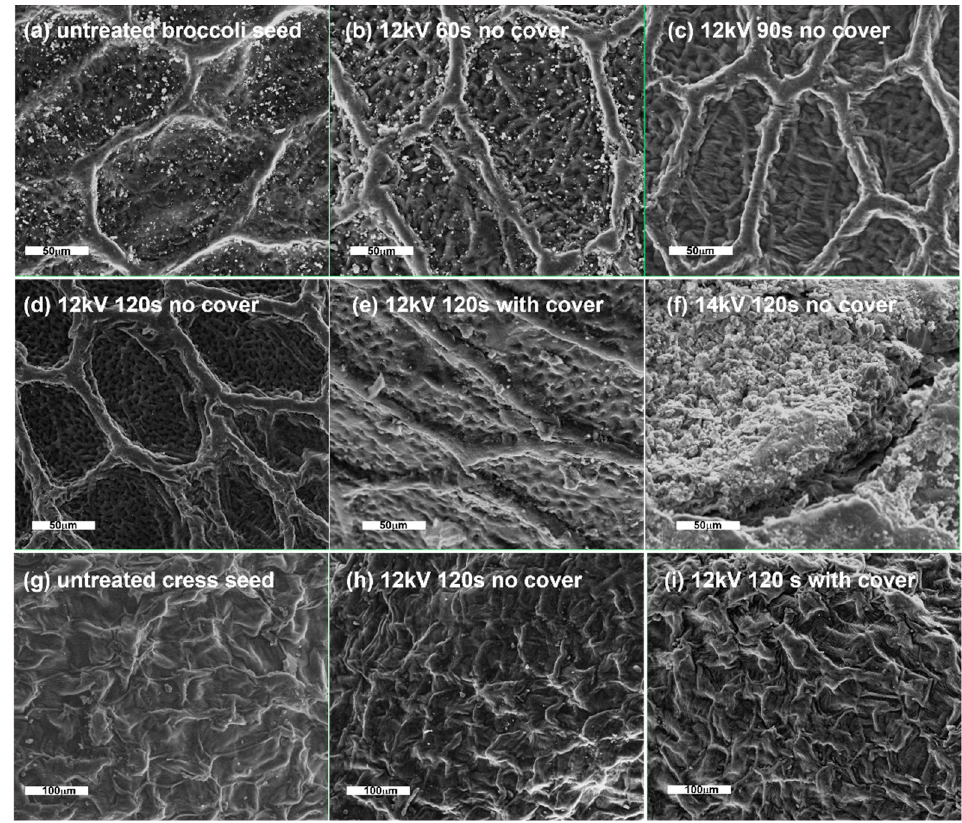
Figure 5. ESEM images of the surface of untreated and treated broccoli ( a – f ) and cress ( g – i ). ( a ) untreated broccoli seed, ( b ) broccoli seed treated with 12 kV NTP for 60 s without cover, ( c ) broccoli seed treated with 12 kV NTP with cover, ( d ) broccoli seed treated with 12 kV NTP for 120 s without cover, ( e ) broccoli seed treated with 12 kV NTP for 120 s with cover, ( f ) broccoli seed treated with 14 kV NTP for 120 s without cover, ( g ) cress seed untreated, ( h ) cress seed treated with 12 kV NTP for 120 s without cover, and ( i ) cress seed treated with 12 kV NTP for 120 s with cover.